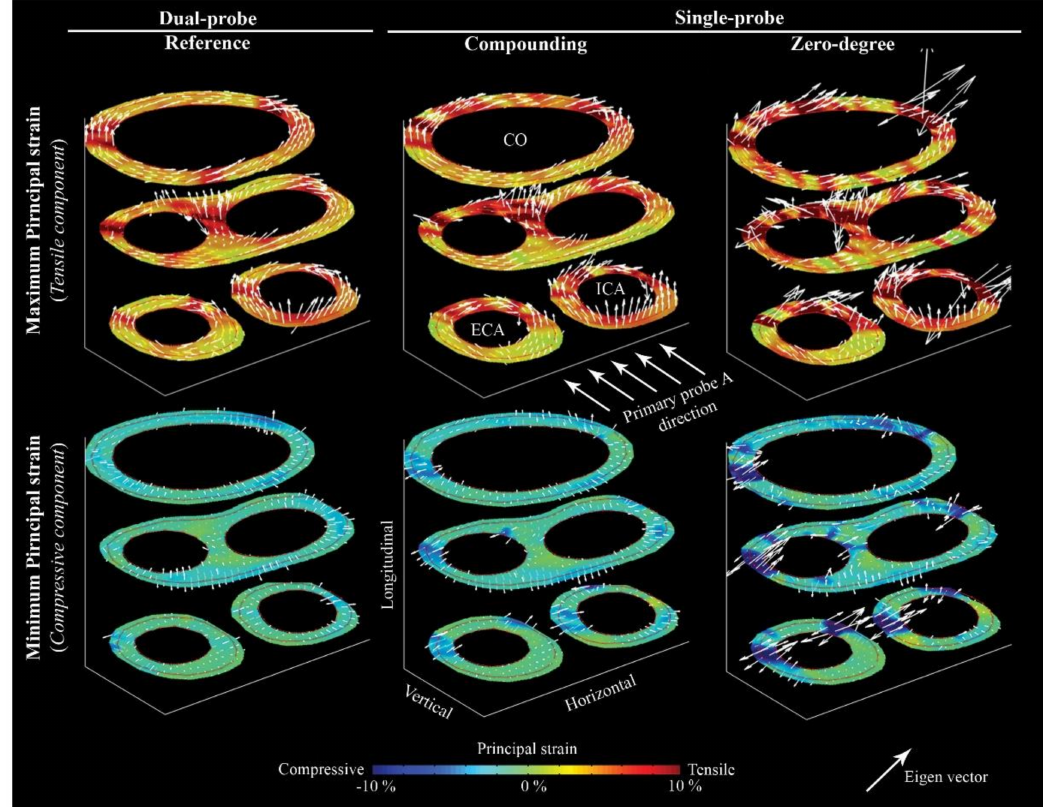
Figure 10. Maximum (tensile) and minimum (compressive) principal strain distributions for probe A for the reference, compounding, and zero-degree method in the bifurcation carotid artery region. Principal strains are visualized at the level of the COmmon carotid artery (CO), bifurcation, and distal from the bifurcation, in which the Internal Carotid Artery (ICA) and the External Carotid Artery (ECA) are present. Please note that the lengths of the eigenvectors were scaled to their corresponding